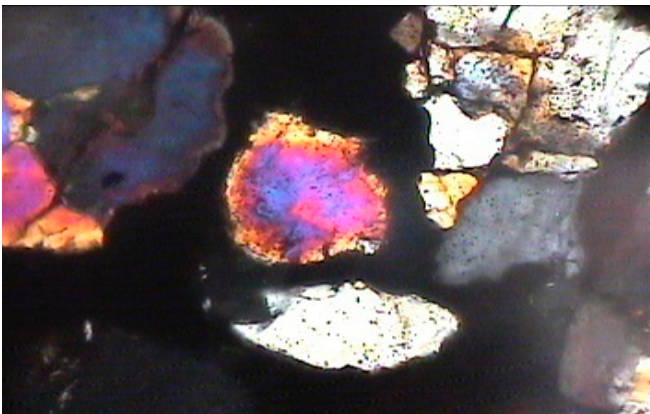
Figure 9. Photomicrograph of mix of nano-sized dry-ground cement and fine aggregates showing dense cement phase and good contact between cement paste and aggregate grains (magnification of 60× under non-polarized light).